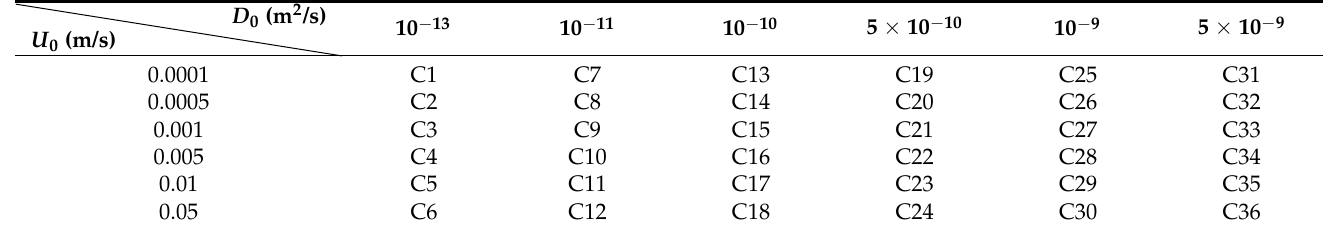
Table 1. Numerical simulation parameters corresponding to condition